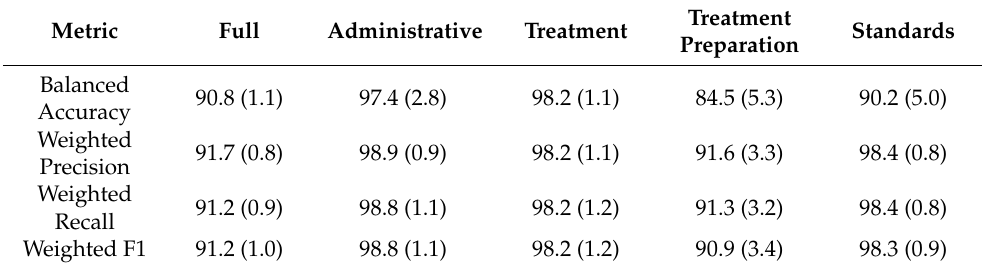
Table 1. Model performance on test data with tf-idf + Linear